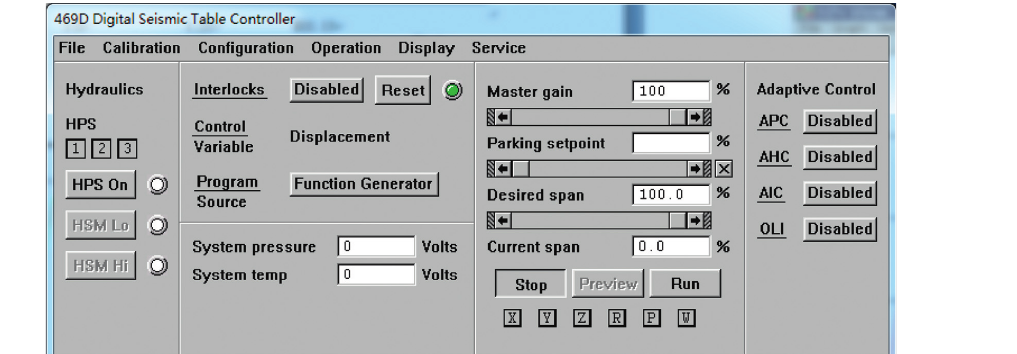
Figure 6: Shaking table.